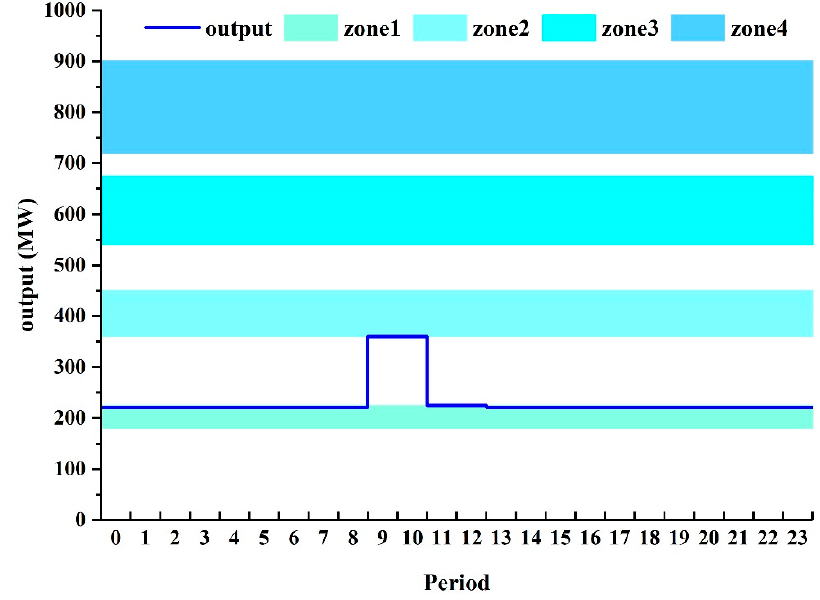
Figure 10. Hourly power generations and operating zones of Gongguoqiao.